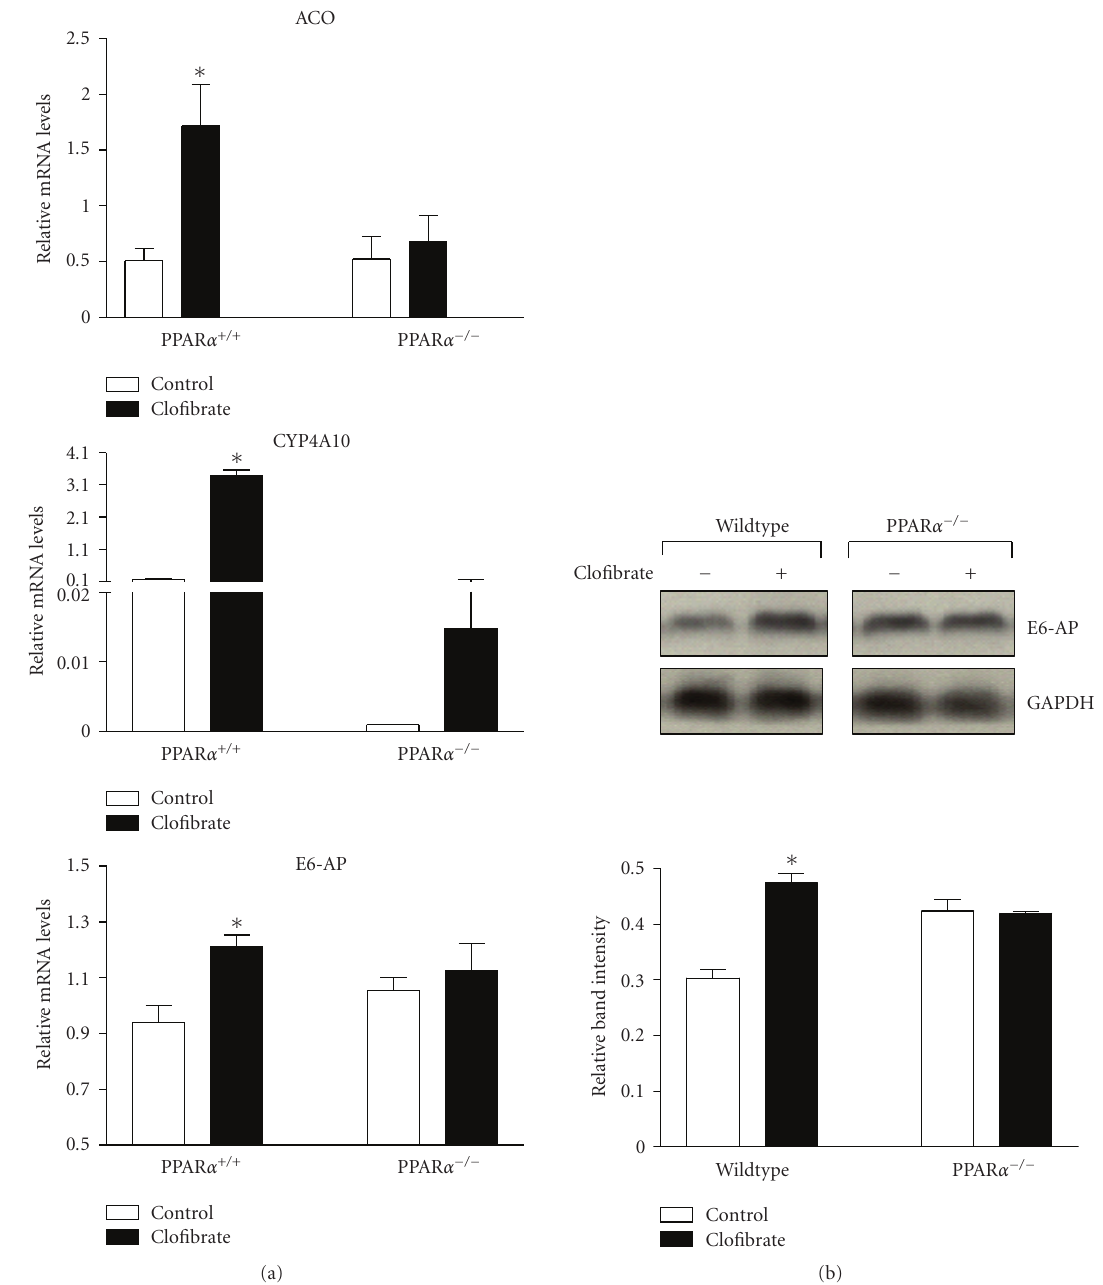
Figure 5: E6-AP is induced by clofibrate in a PPAR α -dependent manner. Wildtype and PPAR α null mice were treated with control vehicle or clofibrate for 2 weeks. Groups of five mice were used for each treatment. (a) Total RNA was isolated from liver and mRNA levels were measured using real-time PCR. (b) Protein isolated from liver was analyzed for E6AP expression by western blot. The graph (lower panel) depicts mean ( n = 5) band intensity. Asterisks indicate a significant increase in clofibrate induction when compared to the PPAR α null group. ( ∗ P < . 05 with statistical analysis using